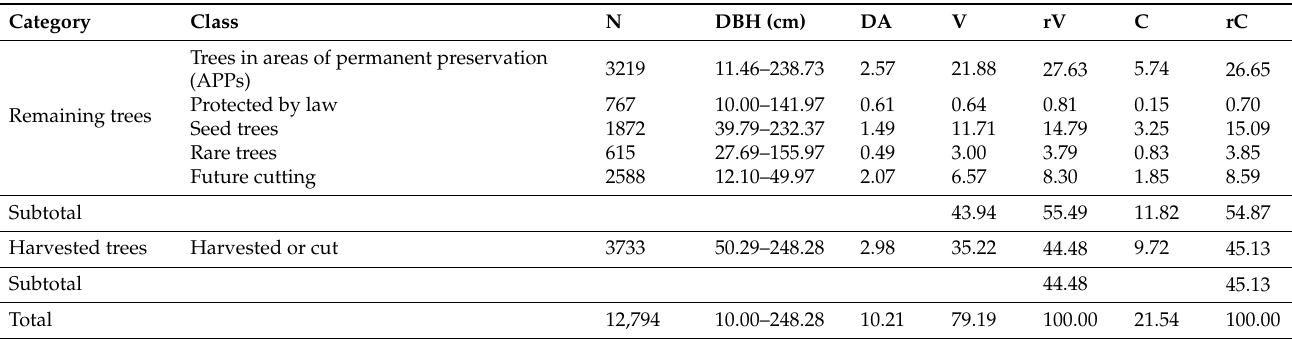
Table 3. Aboveground volume and carbon of commercial trees by category and class for felling and maintenance of the 81 species measured in an area of 1253 ha in the state of Acre,